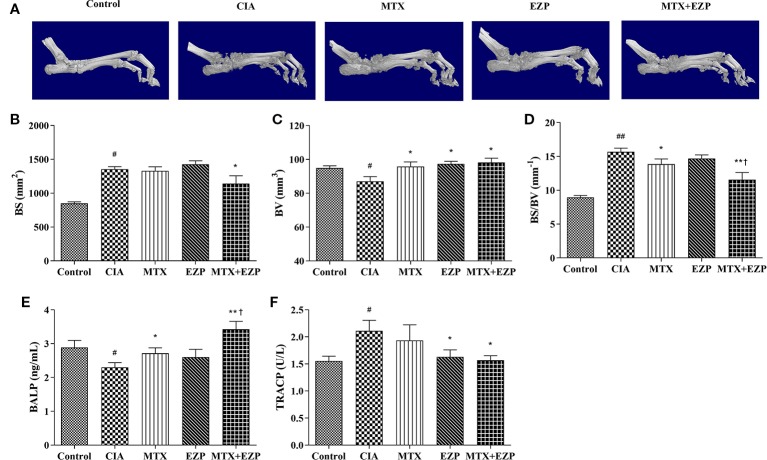
EZP and MTX synergistically reduced bone destruction in CIA rats. (A) Representative micro-CT images of ankle joints after treatment. (B–D) Line plots representing the BS, BV, and BS/BV values of all of the groups. (E–F) Bar plots representing the levels of BALP and TRACP in serum. #P < 0.05, ##P < 0.01 compared with the control group; *P < 0.05, **P < 0.01 compared with the CIA group; †P < 0.05 compared with the MTX group.